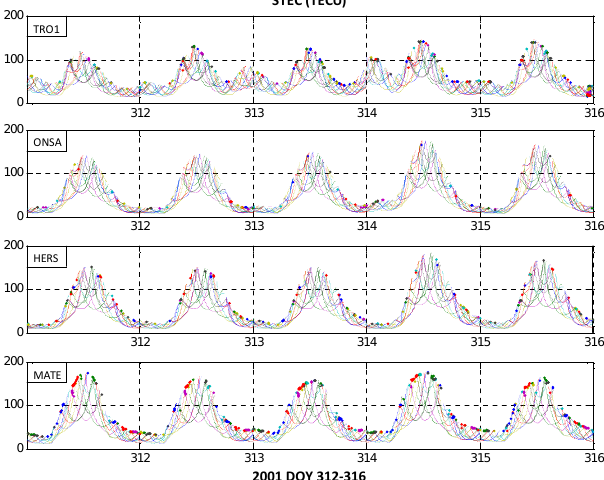
Fig.2. STEC (TECU) for the observation stations on DOY 312‐316 in 2001. Fig. 2. STEC (TECU) for the observation stations on DOY 312–316 in 2001. 1 R Nds term in Eq. (6) is the integral of the electron den- sity ( N ) along LoS between the receiver and satellite inside a columnar cylinder of unit cross sectional area such that the integration gives the (slant) total electron content, along LoS, STEC (1 TEC unit, 1 TECU, is 10 16 e − /m 2 . At times of low background solar activity, as during the quiet periods of the solar cycle, STEC is usually around 20–30 TECU at mid lat- itudes, corresponding to about 3–8 m range delay on GPS L1 frequency giving negligible RREs due to Ion2 and Ion3 terms under these conditions (1 TECU has about 0.16 m delay ef- fect on GPS L1, Kintner Jr., 2006). STEC depends on the ge- ometry of the receiver and satellite link, time of day (with a diurnal variation that attains a peak around local noon), time of year (seasonal dependency) and the solar cycle (greater STEC during peak of the solar cycle). The diurnal variation of STEC on the receiver-satellite links for GPS L1 can be seen for the observation stations in Figs. 2, 5, 8 and 11, for the different levels of solar and geomagnetic conditions. B 0 cos θ term in the Ion2 (Eq. 6) can be taken out of the R Nds , integral assuming that it is LoS-independent, leaving i.e. STEC. Ion3 term contains the integral of the square of the R N 2 ds (Eq. 6), which can be estimated electron density,